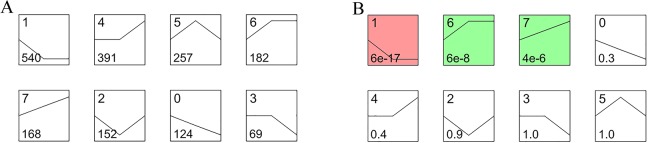
Eight types of gene change tendencies signed with gene numbers.(A): Numbers cited at the upper left corner represent each tendency. Figures cited at the lower left corner represent the number of genes in the tendency. (B): Numbers cited at the upper left corner represent each tendency. Numbers marked at the lower left corner represent the P-value of each tendency type. The colors represent significantly different levels.